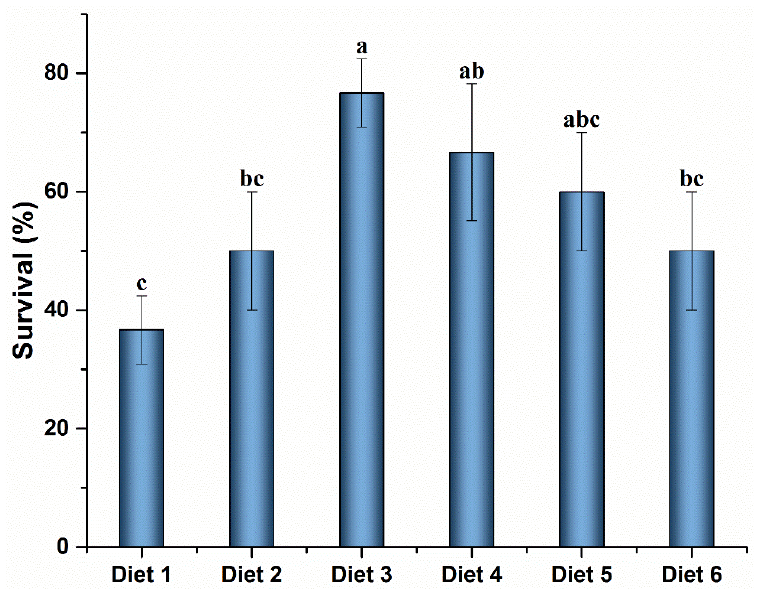
Figure 3. Survival rate of Cherax quadricarinatus fed ELE-supplemented diets under MC-LR stress. Different letters above the error line indicate significant differences ( p <0.05).